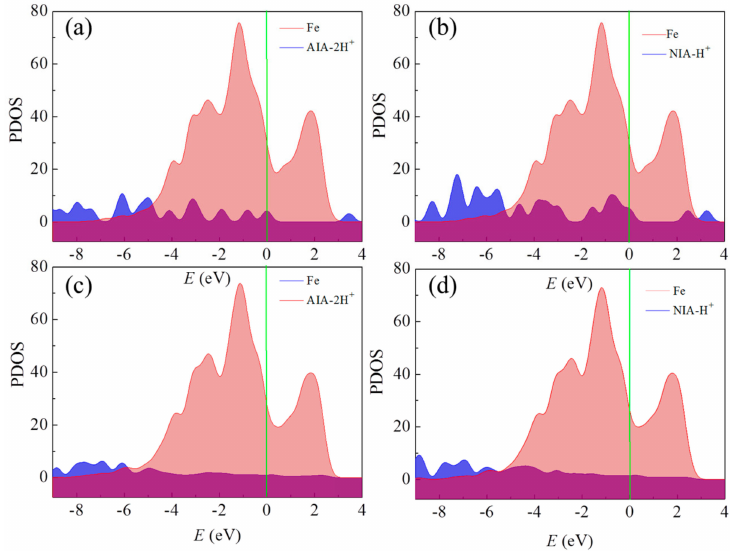
Figure 8. Density states projected of ( a , c ) AIA-2H + and ( b , d ) NIA-H + molecules before and after adsorbing on the Fe(110)